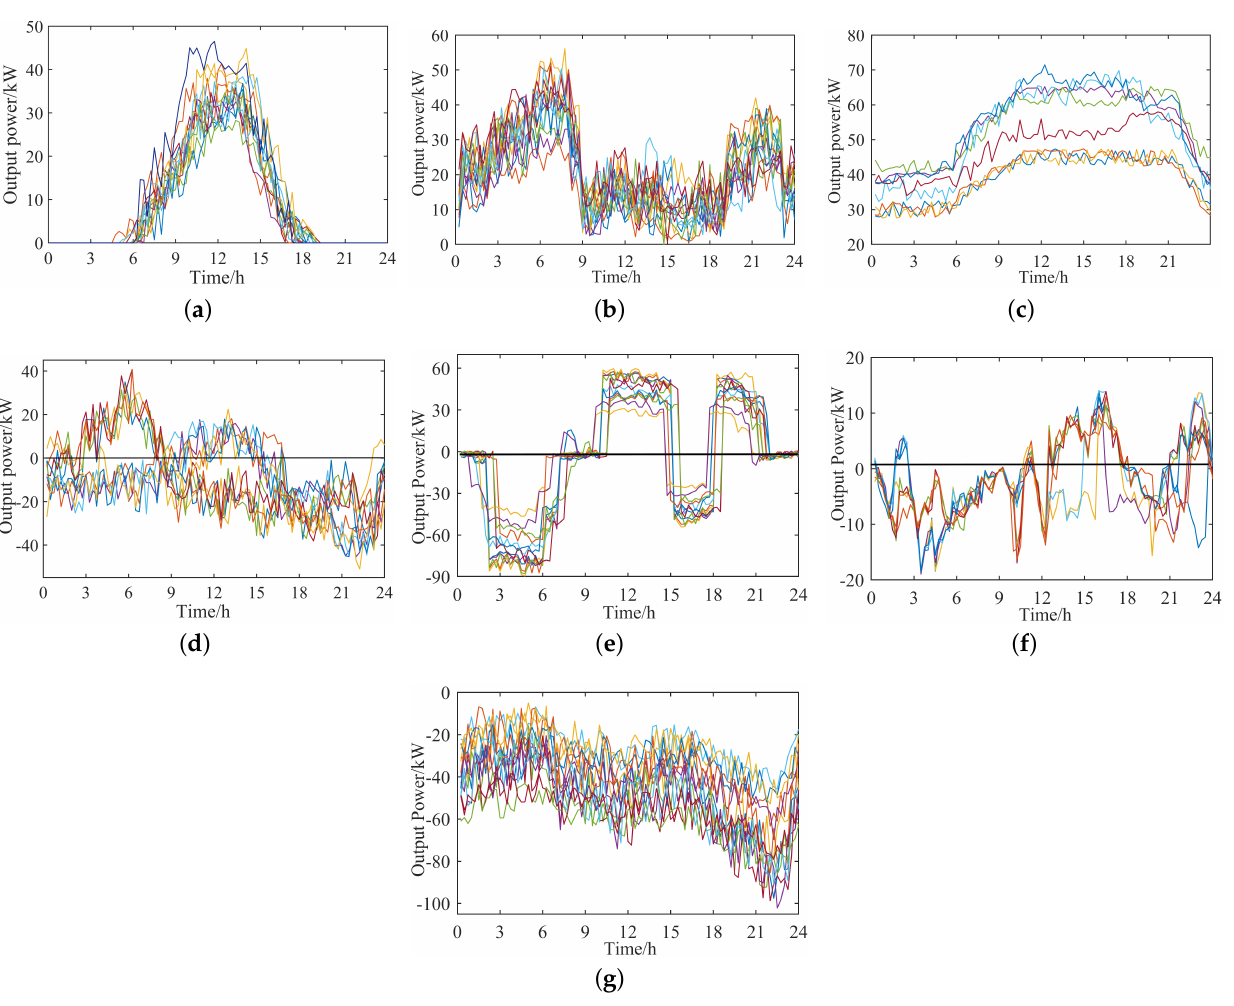
Figure 6. Summary of the output curves of the various distributed units. ( a )Photovoltaic class; ( b )Wind power class; ( c )Controllable generator class; ( d )Prosumer class; ( e )Energy storage class; ( f )Electric vehicle class; ( g )Flexible load